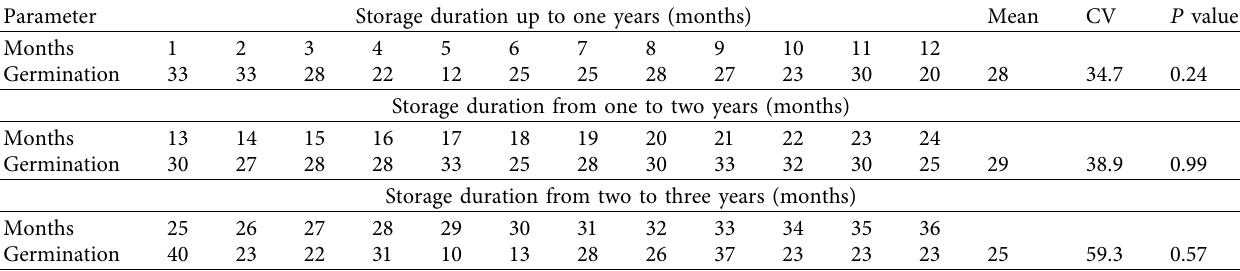
Table 2: Germination performance (%) of tagasaste ( Chamaecytisus palmensis ) seed stored for one, two, and three years. Parameter Storage duration up to one years